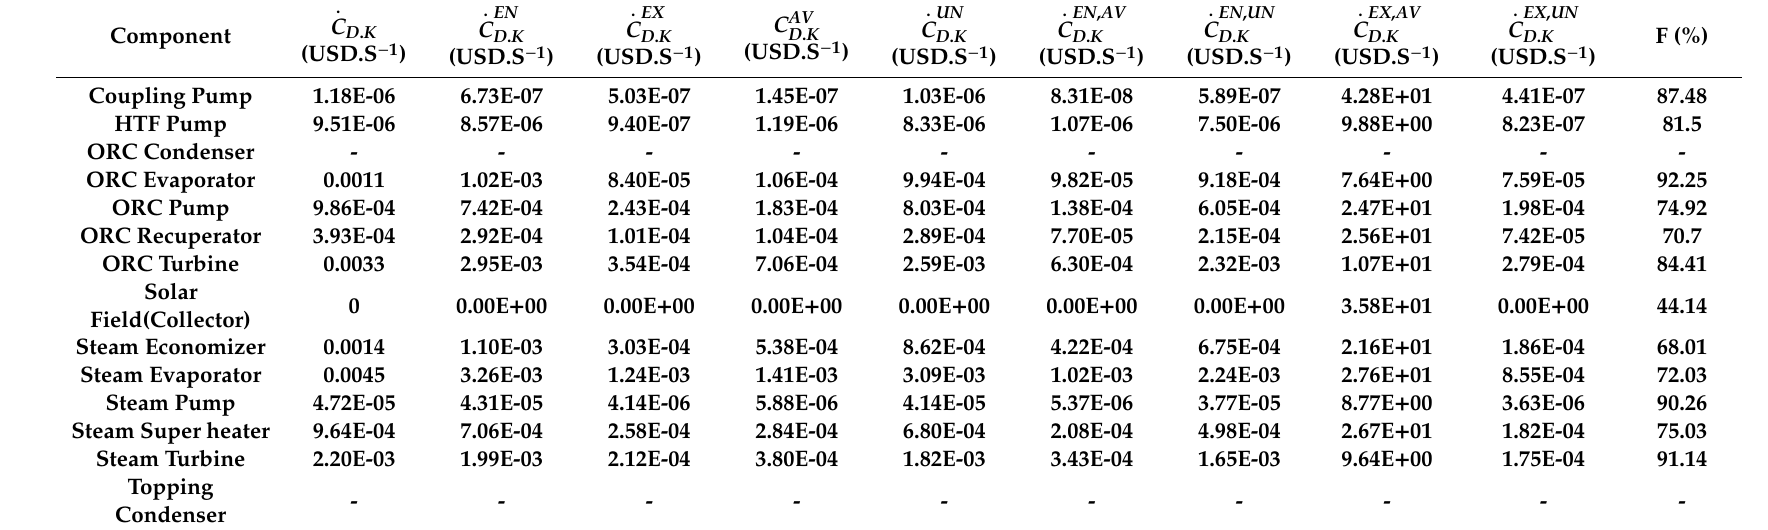
Table 16. Advanced exergo-economic analysis for hybrid solar–geothermal cycle